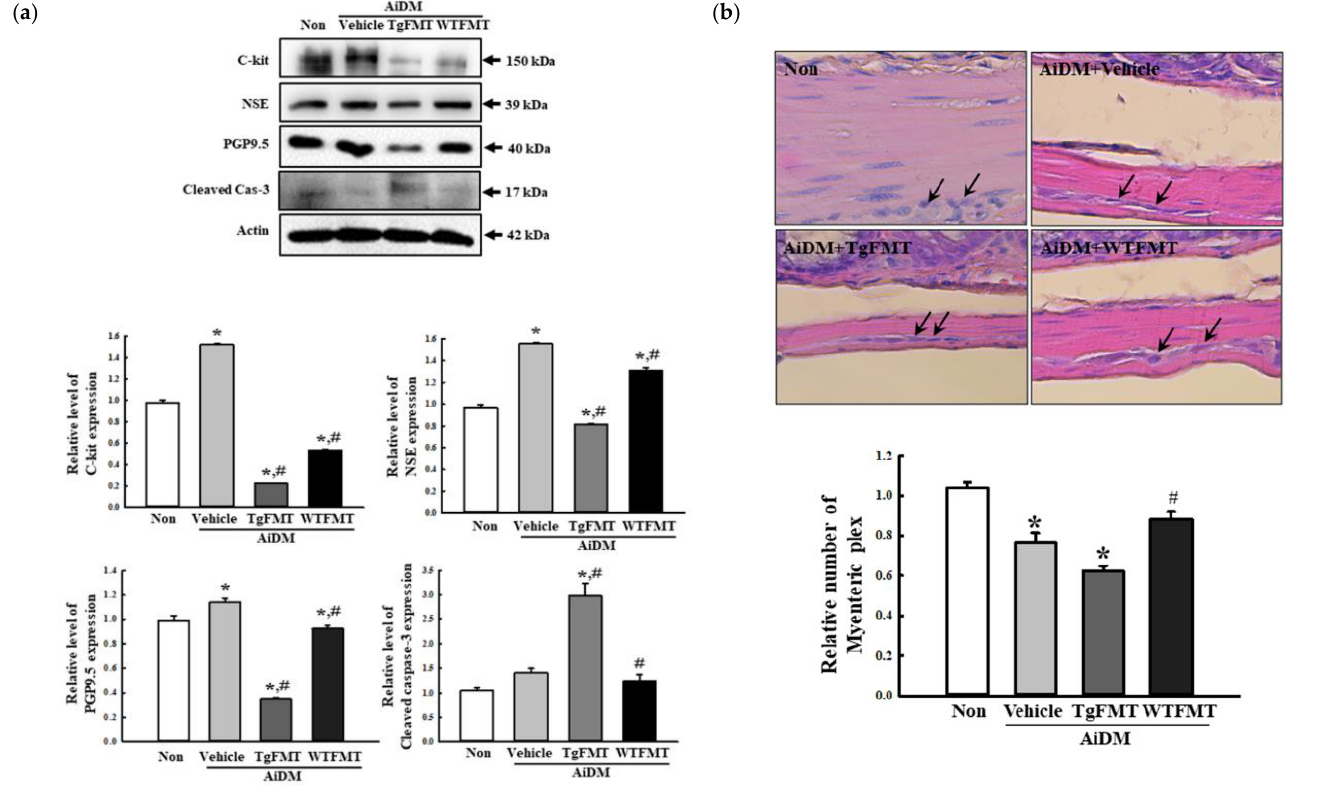
Figure 9. Levels of markers for neuronal cells and ICC in AiDM+TgFMT mice. ( a ) Expression levels of C-kit, NSE, PGP9.5, and Cleaved Cas-3 proteins. The expression of the four proteins in the mid colon was measured with western blot analysis using a specific antibody. The expression level of each protein were represented as the relative level of the β -actin intensity. ( b ) Histological distribution of myenteric plexus. H&E-stained sections of the mid colon from AiDM+WTFMT mice and AiDM+TgFMT mice were observed at 400 × magnification using a light microscope. Black arrow indicated myenteric plexus. H&E-stained slides of the mid colon were prepared from four to six mice per group, and each parameter in their structure was measured in duplicate. The data are reported as the mean ± SD values. *, p < 0.05 compared to the Non-treated group. #, p < 0.05 compared to the AiDM+Vehicle group. Abbreviations: WT, wild-type; Tg, Tg2576 mice; FMT, fecal microbiota transplantation; TgFMT, Tg2576 mice FMT; WFMT, wild-type mice FMT; AiDM, antibiotics-induced depletion of microbiota.